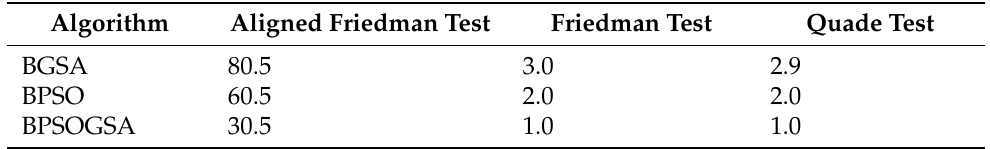
Table 2. Average rankings—KCET